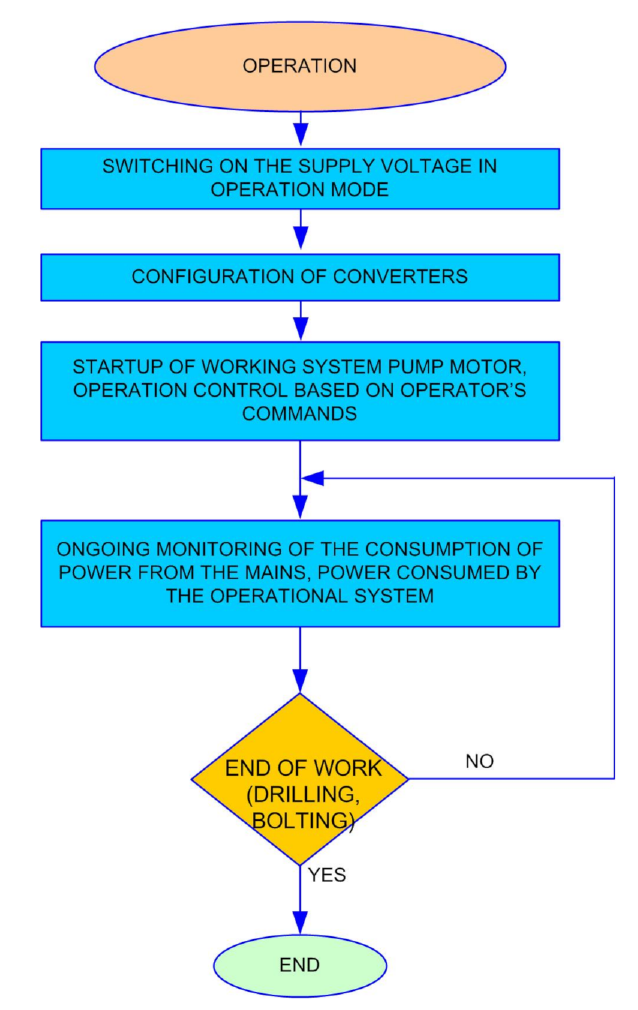
Figure 9. Algorithm controlling the electric power system during